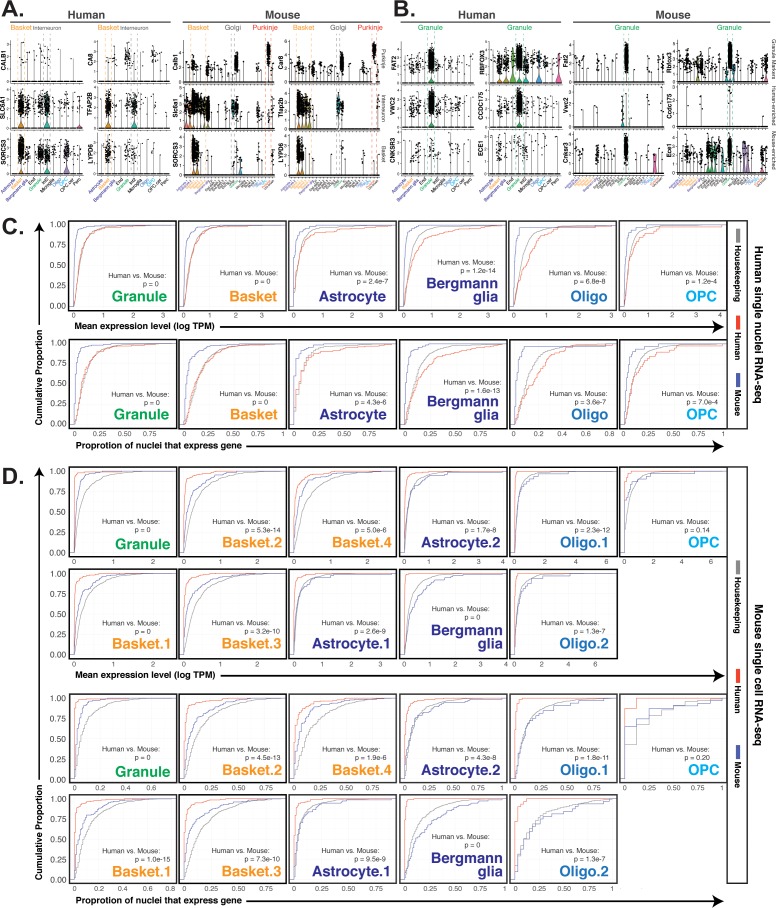
Expression of species-enriched genes in published cerebellar single nuclei/cell RNA-seq data, related to Figure 3.For all figures, human single nuclei RNA-seq data is from (Lake et al., 2018) and mouse single cell RNA-seq data is from (Saunders et al., 2018). Author designations for cell types are used except that Purk1 and Purk2 clusters from (Lake et al., 2018) have been renamed Basket and Interneuron2 (Int2). (A) Violin plots showing expression of Purkinje neuron marker genes CALB1/Calb1 and CA8/Car8 (top), cerebellar interneuron marker genes SLC6A1/Slc6a1 and TFAP2B/Tfap2b (middle), and basket neuron marker genes SORCS3/Sorcs3 and LYPD6/Lypd6 (bottom) in human and mouse cerebellar cell types. (B–D) Expression of mouse and human-enriched genes identified in this study in cell nuclei/cell data. (B) Violin plots showing expression values for the granule marker genes FAT2/Fat2 and RBFOX3/Rbfox3, human-enriched granule cell genes VWC2/Vwc2 and CCDC175/Ccdc175, and mouse-enriched granule cell genes CNKSR3/Cnksr3 and ECE1/Ece1. (C) For each cell type in human cerebellar single nuclei RNA-seq data, empirical cumulative distribution function (ECDF) plots show expression of housekeeping, human-enriched, or mouse-enriched genes in single nuclei data. Top row: distributions of mean expression levels; bottom row: proportion of nuclei with expression greater than one log2(TPM). Kolmogorov Smirnov test p-values comparing the distribution of human-enriched versus mouse-enriched genes are shown. Distribution of human- and mouse-enriched astrocyte genes are shown in both astrocytes and Bergmann glia. (D) For each cell type in mouse cerebellar single nuclei RNA-seq data, ECDF plots show expression of housekeeping, human-enriched, or mouse-enriched genes in single nuclei data. Top two rows: distributions of mean expression levels; bottom two rows: proportion of nuclei with expression greater than one log2(TPM). Kolmogorov Smirnov test p-values comparing the distribution of human-enriched versus mouse-enriched genes are shown. Distribution of human- and mouse-enriched astrocyte genes are shown in astrocytes and Bergman glia, basket cell genes are shown in basket cell subtypes 1 through 4, and oligodendrocyte genes are shown in oligodendrocyte subtypes 1 and 2.